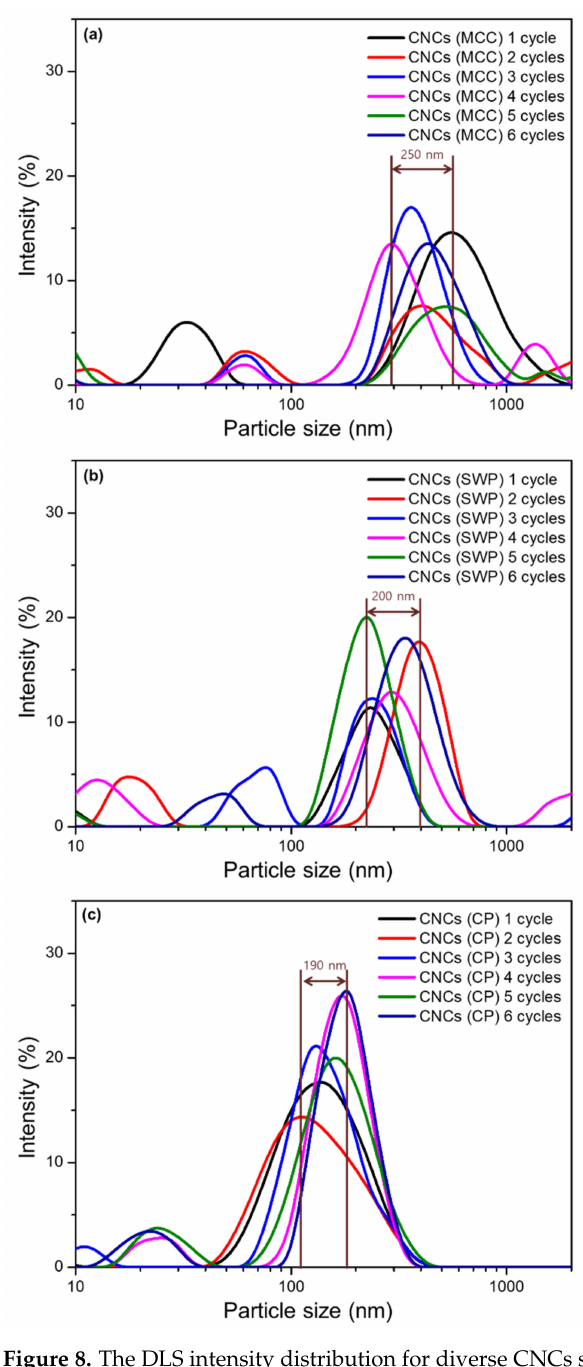
Figure 8. The DLS intensity distribution for diverse CNCs suspensions according to HPH treatment: ( a ) Isolated CNCs from MCC, ( b ) isolated CNCs from SWP, ( c ) isolated CNCs from CP. For the three samples, it can be seen that the isolation degree, turbidity, surface charge and stability of the CNCs suspension showed a trend as the HPH treatment increased. However, in the case of CNCs (SWP), the sample of HPH treatment applied six times showed a slightly lower stability than the sample of HPH treatment applied five times because the length of CNCs was larger. As mentioned above, since the high-pressure homogenizer treatment showed a fractionation degree of 90% or more with only three times, some deviation of data may be seen in the treatment three times or